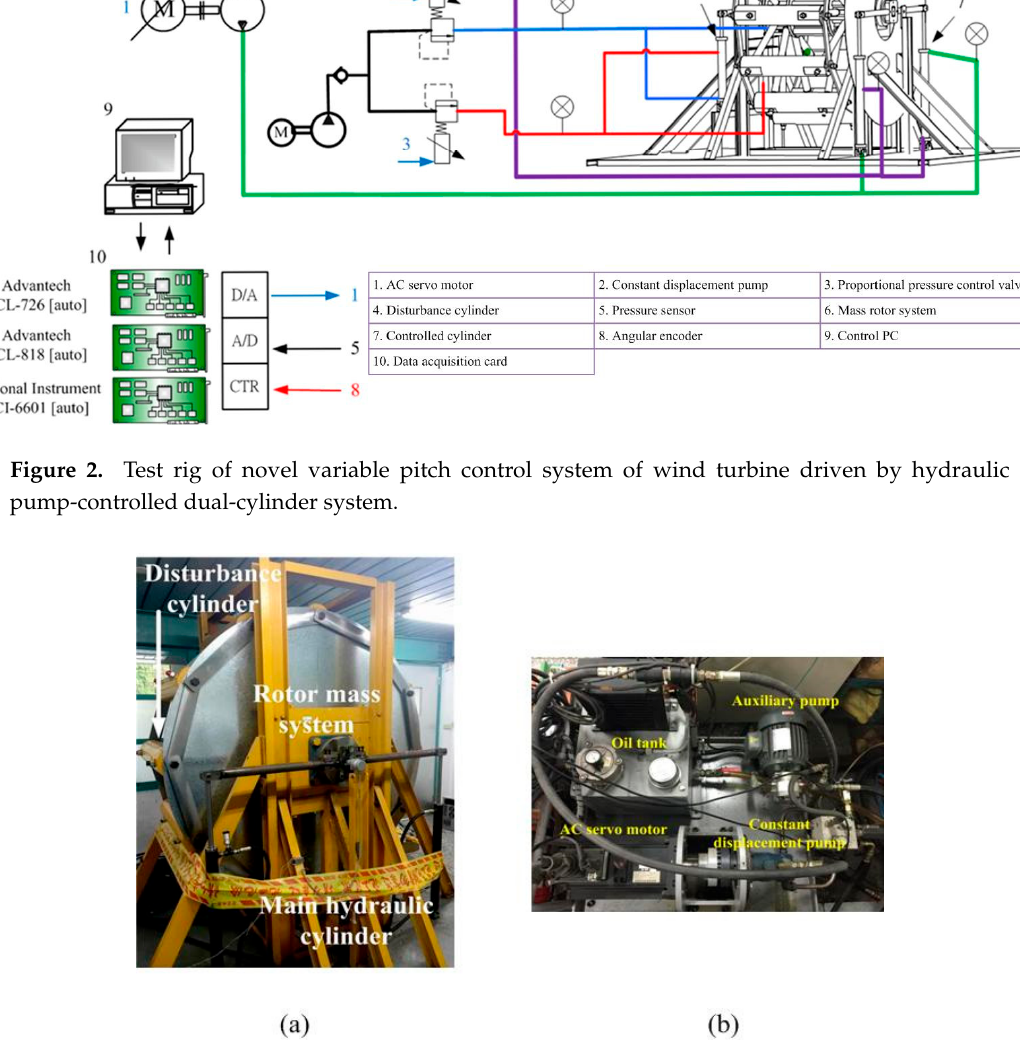
Figure 3. Photograph of test rig of novel hydraulic pitch control system: ( a ) rotor mass system; ( b ) variable pump controlled system.